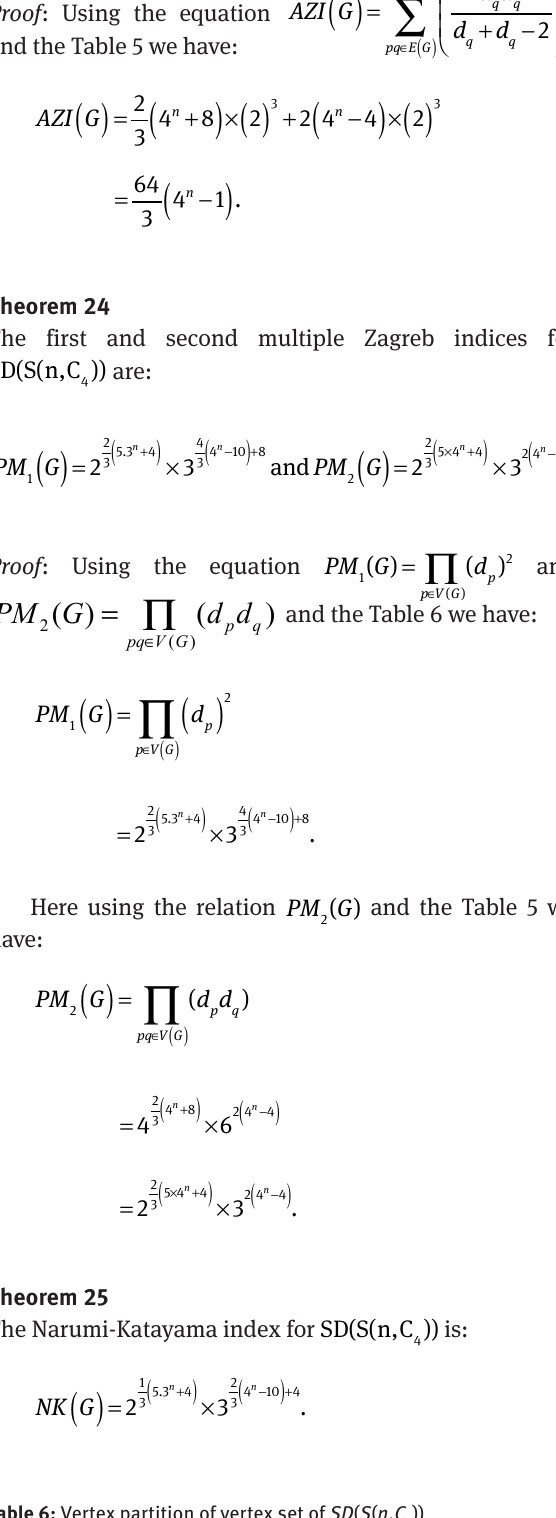
Table 6: Vertex partition of vertex set of SD ( S ( n , C d p Number of the